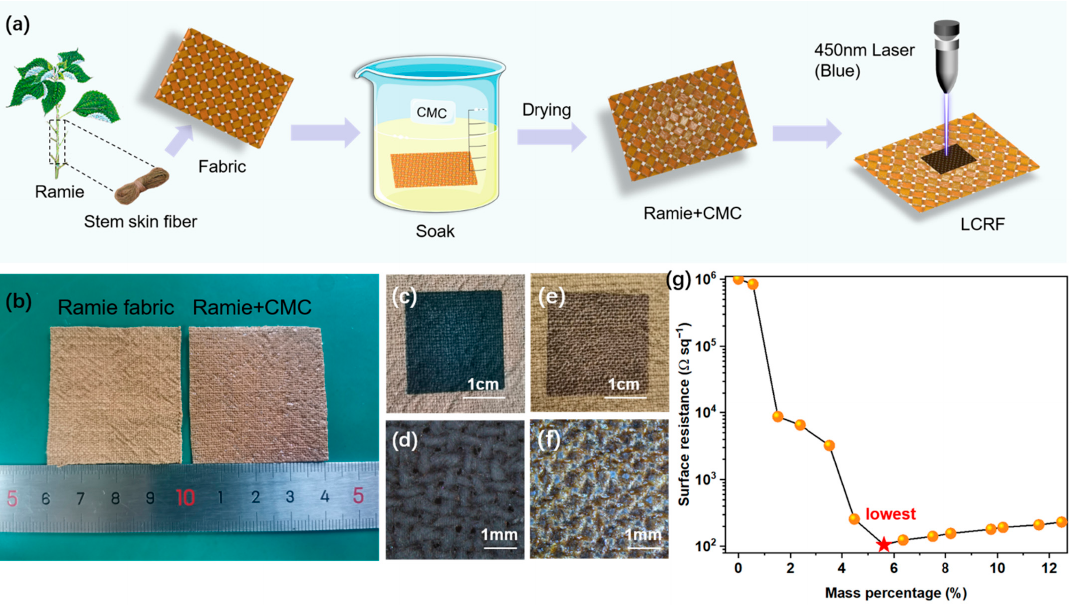
Figure 1. ( a ) Schematic illustration of the fabrication for LCRF. ( b ) photographs of untreated ramie fabric and ramie fabric treated with CMC. ( c , d ) surface morphology of carbonized ramie fabric treated with CMC. ( e , f ) surface morphology of carbonized untreated ramie fabric. ( g ) surface resistance of LCRF adding CMC with different mass